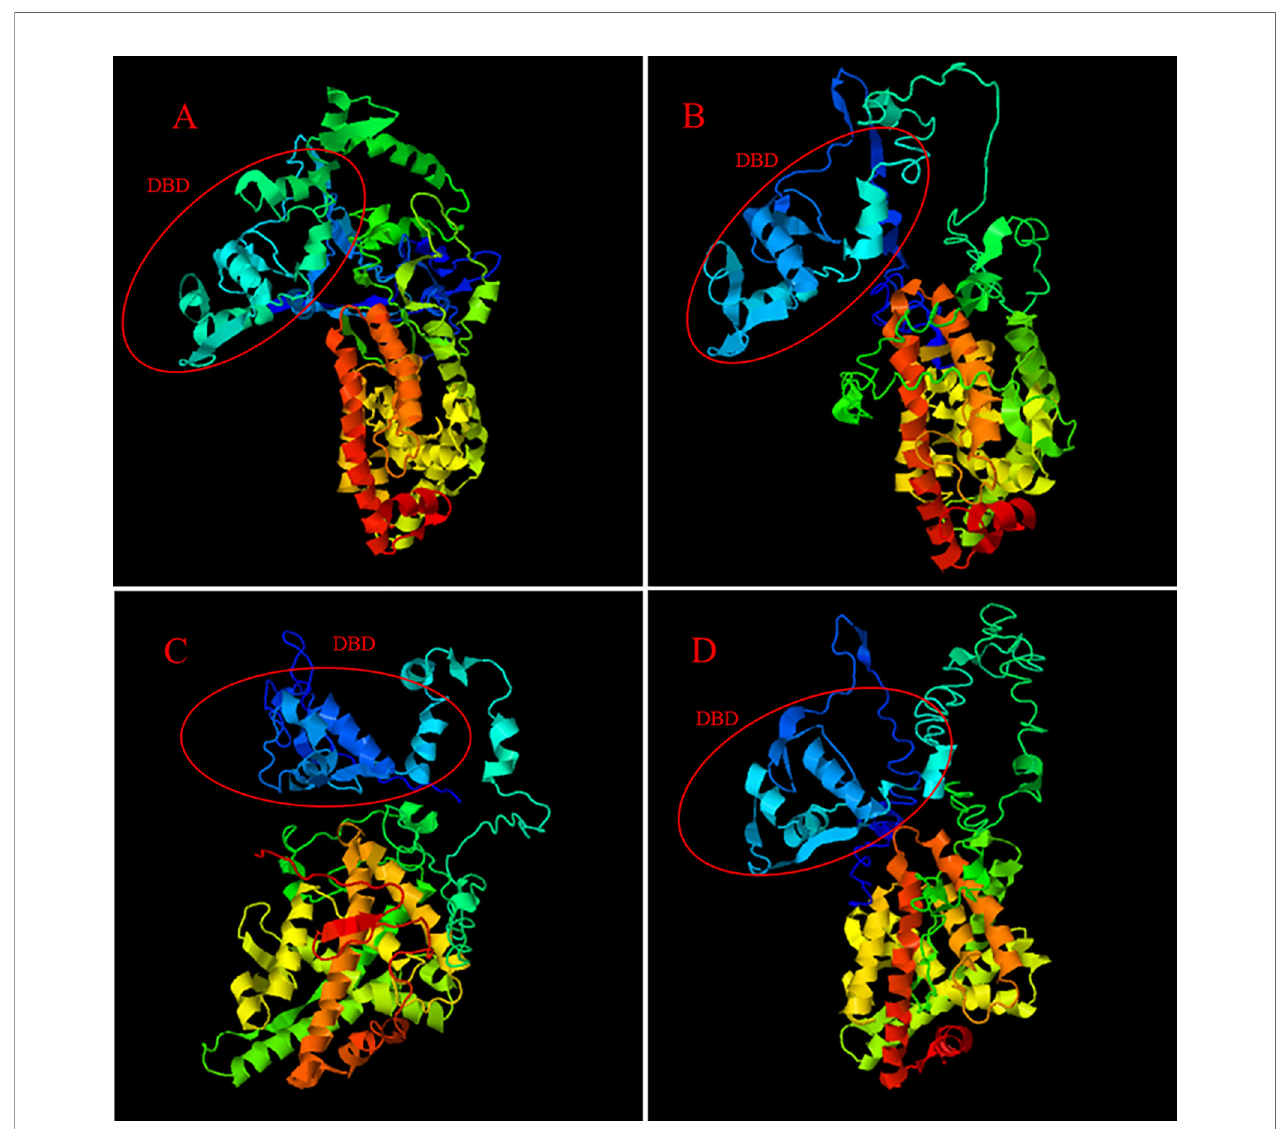
FIGURE 4 | The 3D-structures of MnFtz-f1 and Ftz-f1 predicted by I-TASSER. (A) shows the 3D-structure of the MnFtz-f1 gene of M. nipponense . (B – D) show the 3D-structures of the Ftz-f1 gene of P. vannamei , H. americanus and P. monodon , respectively. The DNA-binding domain is marked with a red